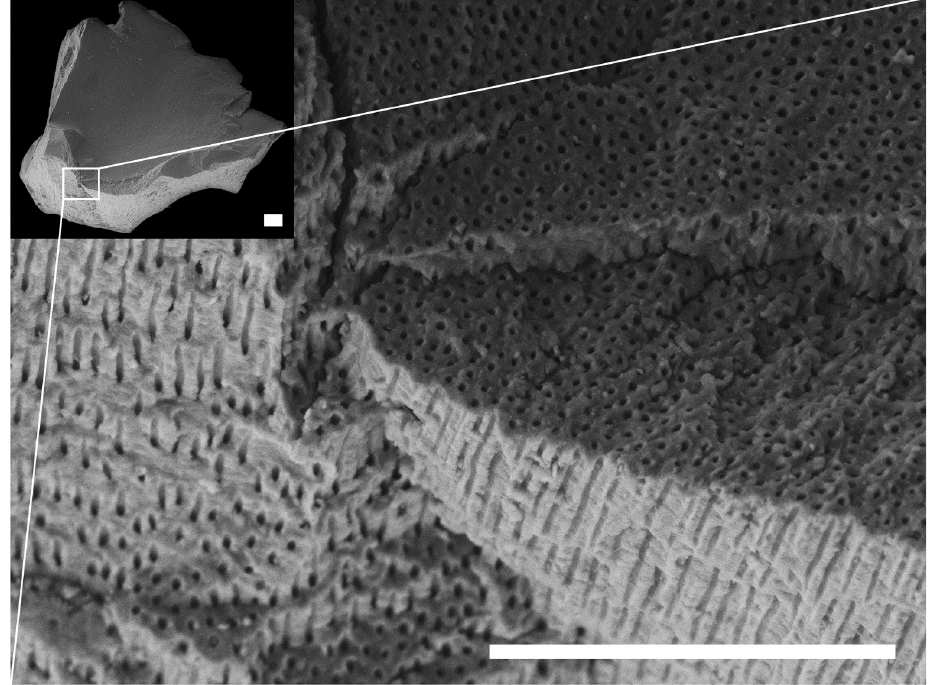
Fig 4. Supragingival calculus sample from lingual surface of right M 1 , individual SK 62, KDK1. Example of dental calculus sample with pores arranged perpendicular to the proximal interface (interface that previously adjoined the tooth surface). Scale bar (100 μ m) applies to both